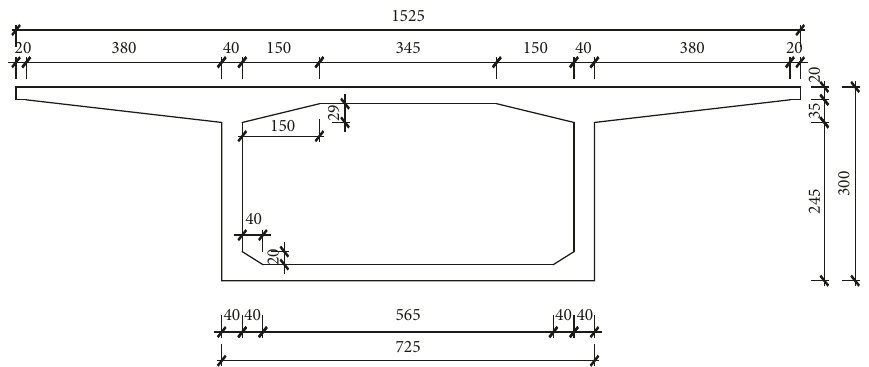
Figure 1: Midspan cross section of 5 × 50m simple-continuous box girder of Donghai Bridge (mm).